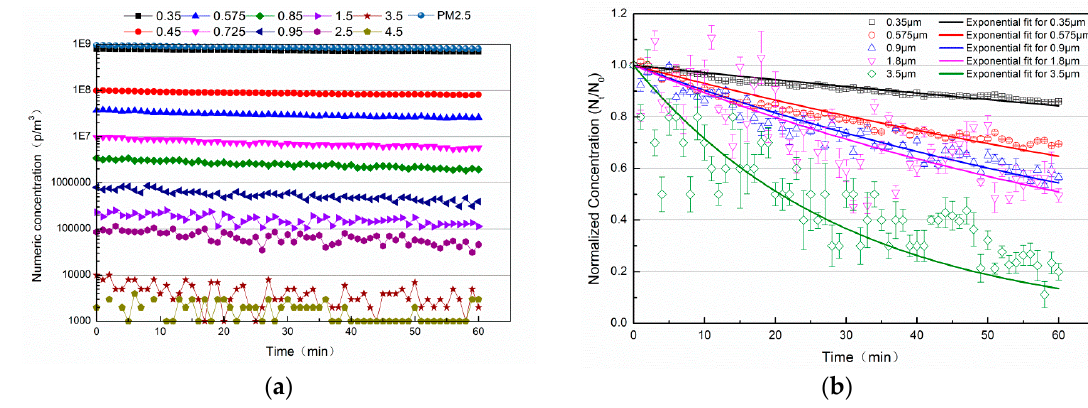
Figure 9. Numeric and normalized concentration over time of indoor particles with different particle sizes with natural decay. ( a ) Numeric concentration; ( b ) Normalized concentration. Table 5. The natural decay constant over 1 h of particles with various particle sizes and the corresponding residual sum of squares.